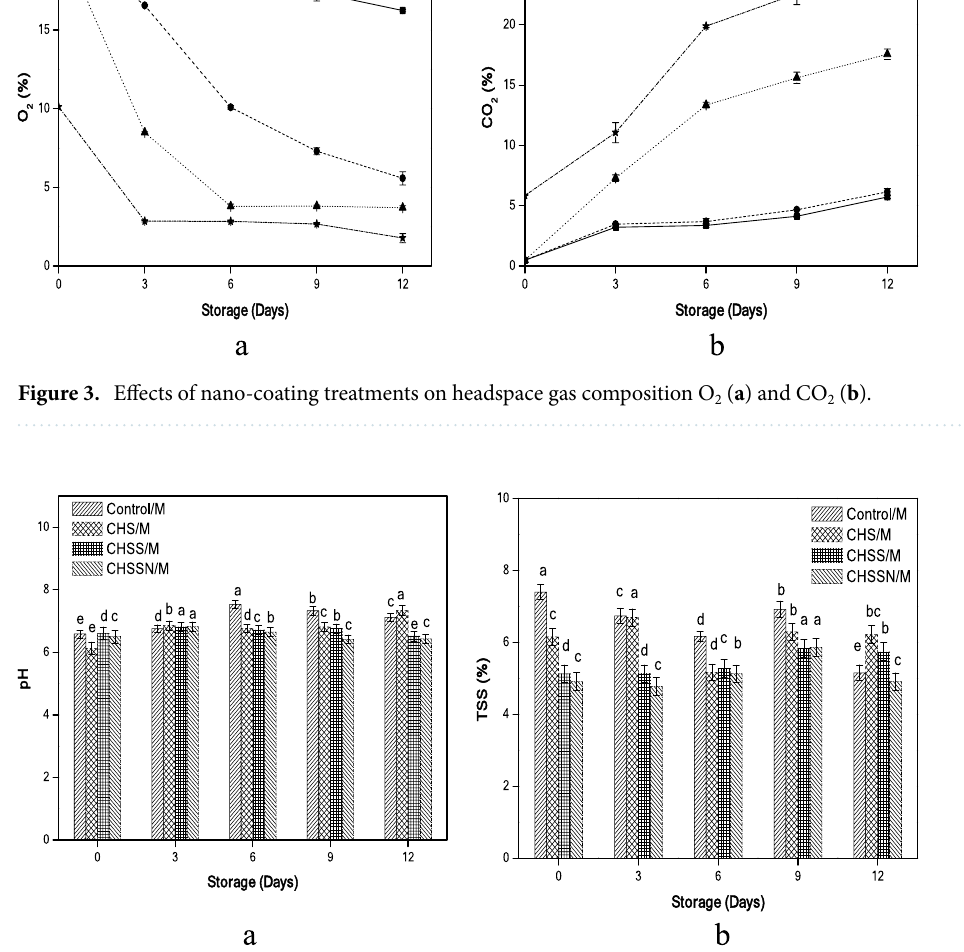
Figure 4. Effects of nano-coating treatments on active acidity ( a ) and total soluble solids concentrations ( b